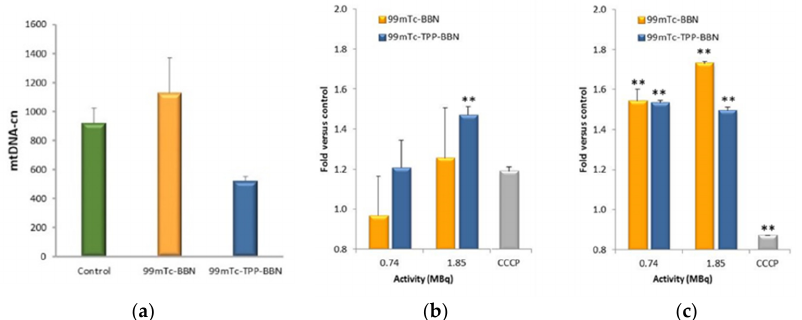
Figure 9. Evaluation of the mitochondrial effect. ( a ) Mitochondrial DNA copy number (mtDNA-cn) of PC3 cells after 2 h of incubation with 9.25 MBq/mL of 99m Tc-BBN and 99m Tc-TPP-BBN at 37 ◦ C. Cells only with the regular medium were used as the control. ( b ) Membrane integrity and ( c ) ATP levels for PC3 cells treated for 2 h at 37 ◦ C with 0.74 and 1.85 MBq of 99m Tc-BBN and 99m Tc-TPP-BBN . Cells incubated with the assay medium (HBSS supplemented with galactose and 1% BSA) were used as a basal control, and cells incubated with CCCP (10 µ M) as a positive control for mitochondrial inhibition. The data are represented as the fold versus the basal control. The data correspond to the mean ± SEM of 3 replicates (** p < 0.01 versus the